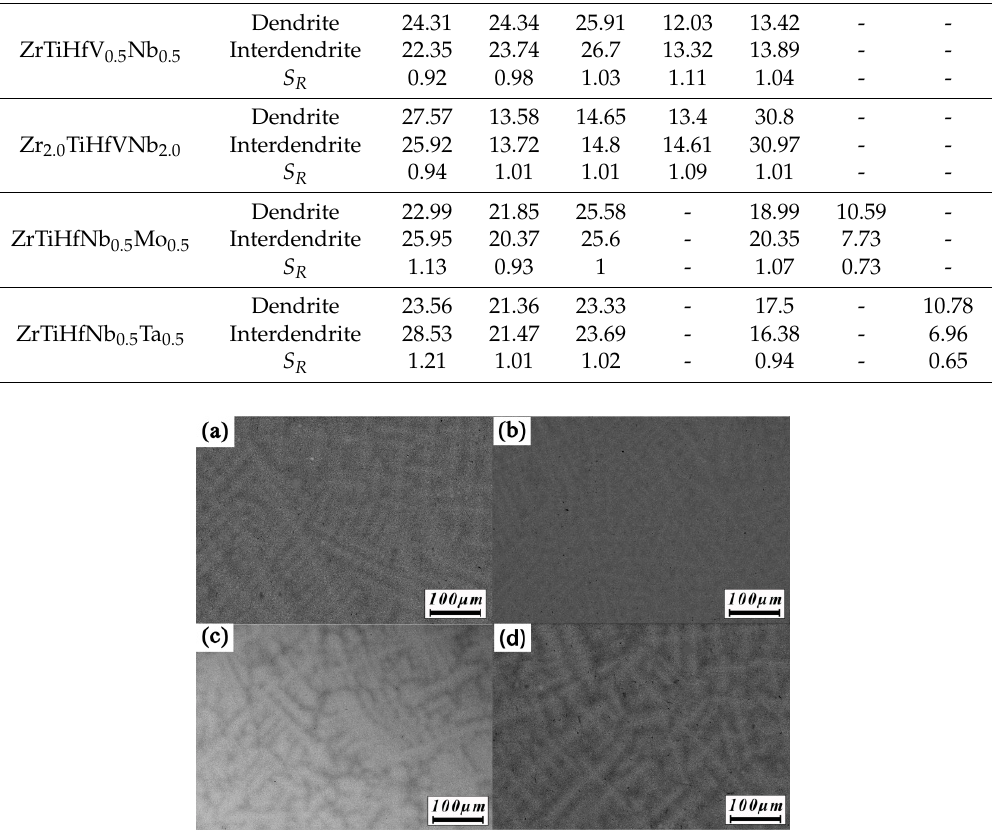
Figure 3. Backscattered electron (BSE) images of the as-cast RHEAs: ( a ) ZrTiHfV 0.5 Nb 0.5 ; ( b ) Zr 2.0 TiHfVNb 2.0 ; ( c ) ZrTiHfNb 0.5 Mo 0.5 ; ( d ) ZrTiHfNb 0.5 Ta 0.5